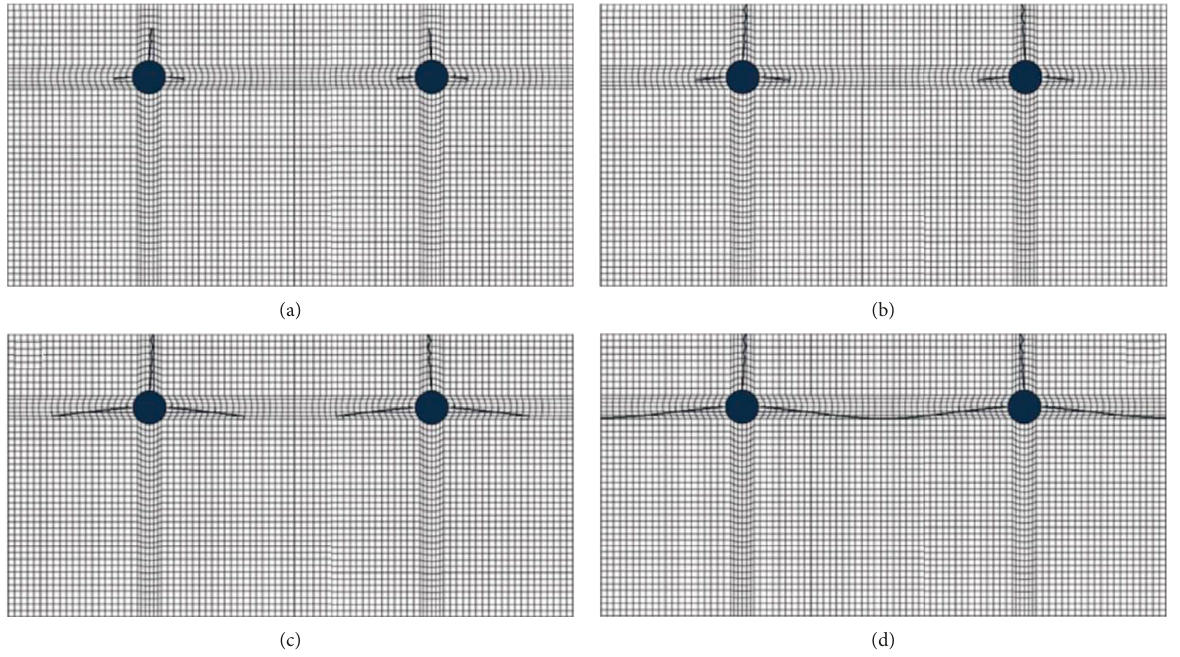
Figure 9: Concrete cover-cracking process when t � 77d (a), 172d (b), 286d (c), and 558d (d) under uniform distribution of corrosion